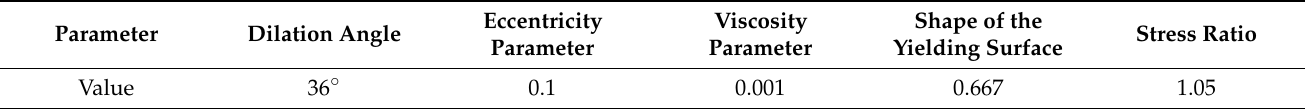
Figure 4. Illustration of the constitutive relationships of ( a ) concrete in compression; ( b ) concrete in tension; and ( c ) steel bars. Table 2. Parameters used in the CDP